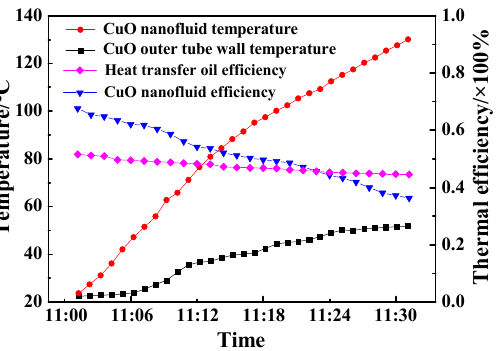
Figure 13. Temperature and instantaneous thermal e ffi ciency curves of CuO / oil nanofluids and the outer tube wall as a function of time.